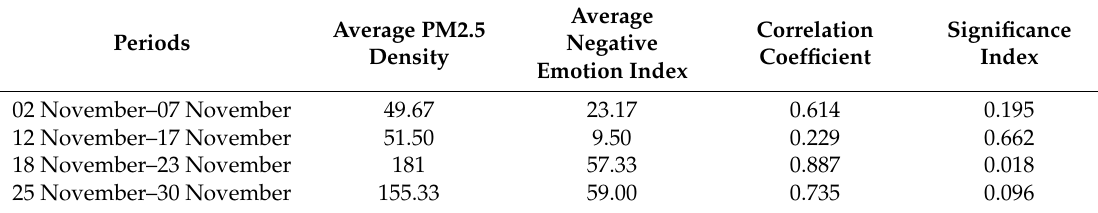
Table 7. Statistics and correlation analysis results of the four periods in Table 6. Statistics and correlation analysis results of the four periods in November.